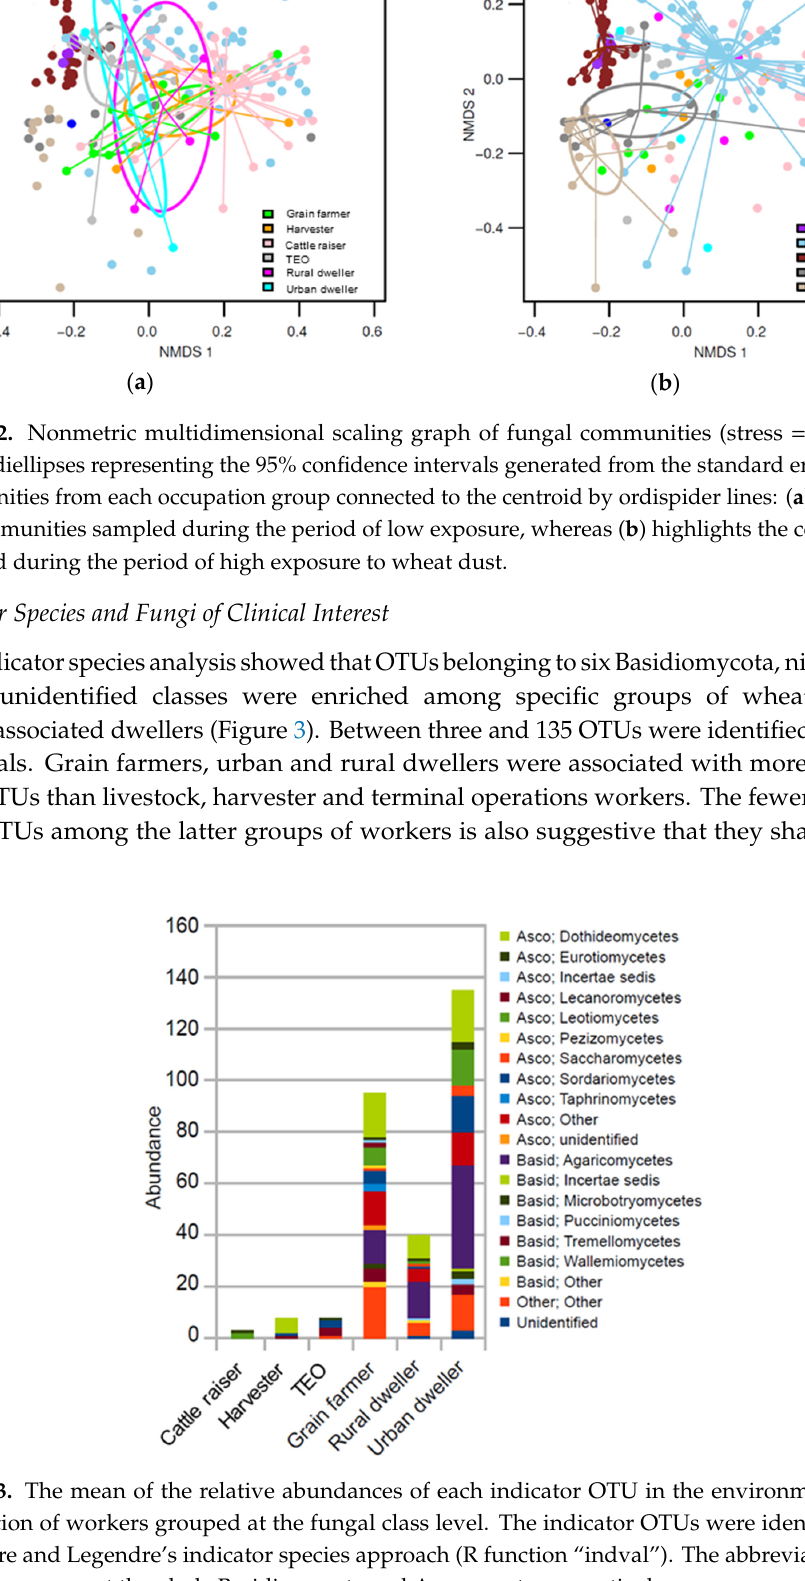
Figure 3. The mean of the relative abundances of each indicator OTU in the environment of each population of workers grouped at the fungal class level. The indicator OTUs were identified using Legendre and Legendre’s indicator species approach (R function “indval”). The abbreviations Basid and Asco represent the phyla Basidiomycota and Ascomycota, respectively